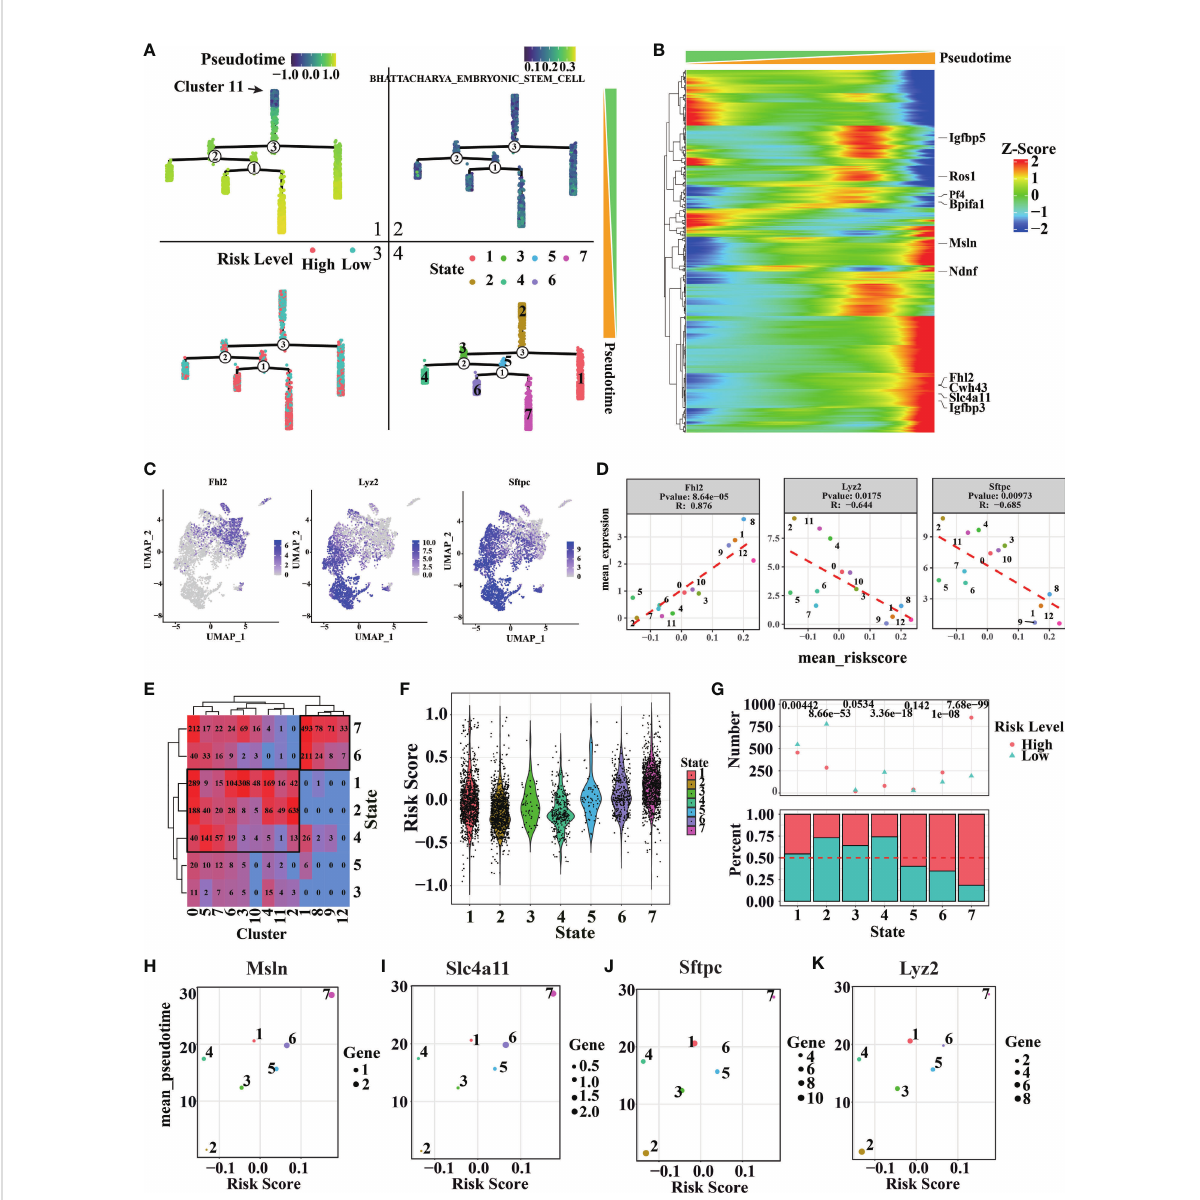
FIGURE 8 Cell trajectory and pseudotime analysis of LUAD by scRNA-seq. (A1) Distribution of pseudo-time values of different cells in the minimum spanning tree. (A2) The distribution of BHATTACHARYA_EMBRYONIC_STEM_CELL score in the minimum spanning tree. (A3) Distribution of risk rating in the minimum spanning tree. (A4) Distribution of different cell states in the minimum spanning tree. (B) Genes related to pseudo-time series, the genes marked on the right are the 10 genes with the strongest correlation. (C, D) Distribution and correlation of pseudo-time related genes and branching related genes. (E) The relationship between cell states and clusters in different pseudo-time series, the number represents the number of cells in the corresponding state. (F) Cell risk values corresponding to different quasi-sequential states. (G) Ratio of cell risk states corresponding to different pseudo temporal states (above: the top number represents the signi fi cance of binomial distribution test; below: the ratio of high-risk cells to low risk cells in each state). (H) Scatter plot of Msln expression mean and risk mean of cells in different states. (I) Scatter plot of Slc4a11 expression and risk score of cells in different states. (J) Scatter plot of Sftpc expression and risk score of cells in different states. (K) Scatter plot of Lyz2 expression average and risk average of cells in different